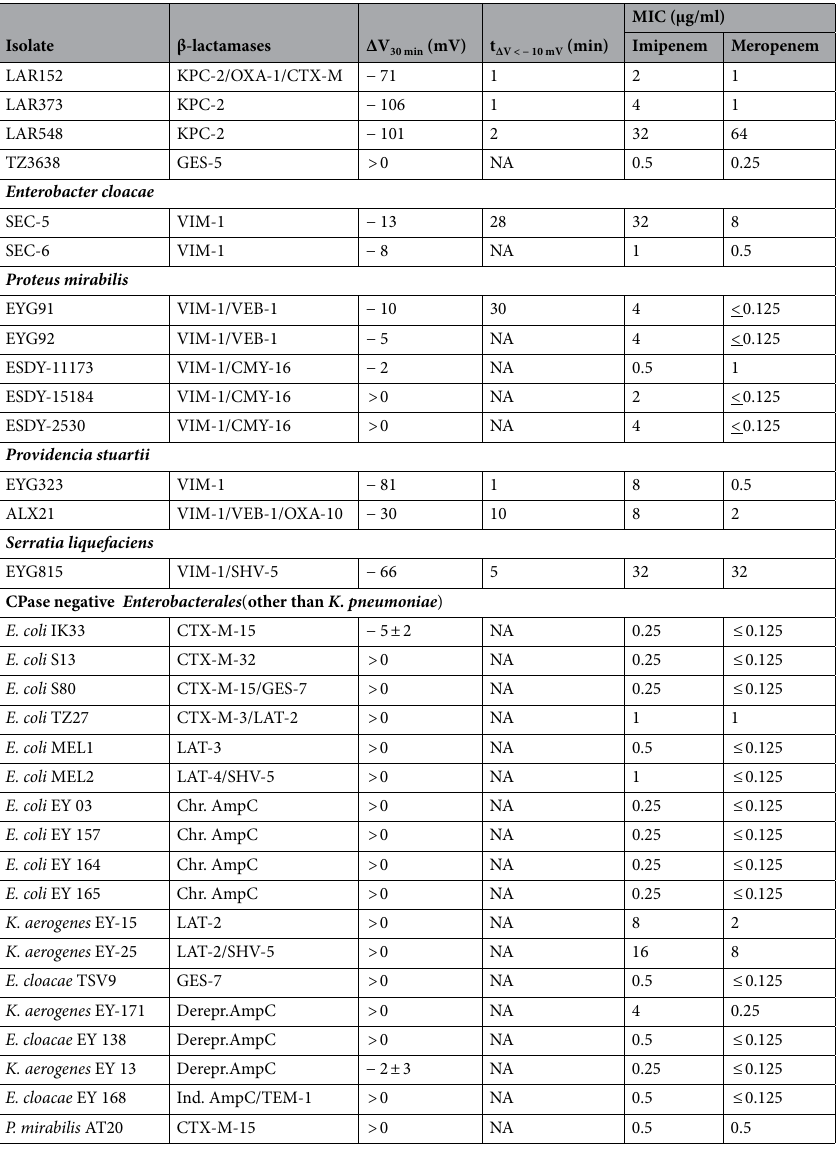
Table 3. Application of the ISFET method on clinical isolates. Derepr. AmpC: De-repressed expression of the chromosomal cephalosporinase, Ind. AmpC: Inducible expression of the chromosomal cephalosporinase,